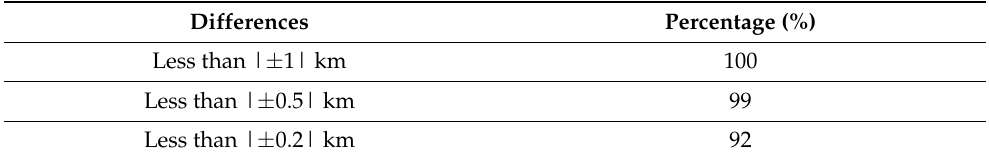
Table A1. The Moho depth differences obtained by solving the VMM problem by using the EGM2008 and EIGEN-6C4 gravitational models. Unit: Percentage (%).